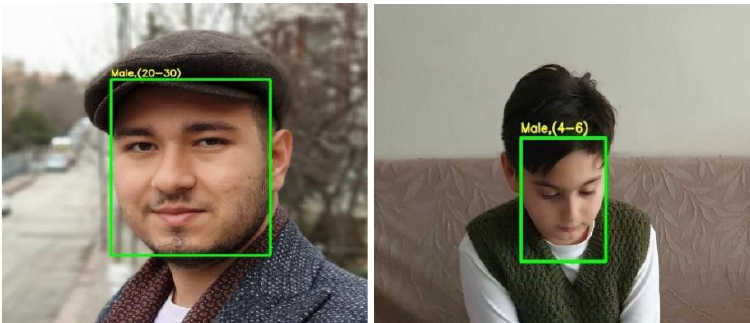
Fig. 7. Age and gender classification of a young adult and a child via CNN architecture.